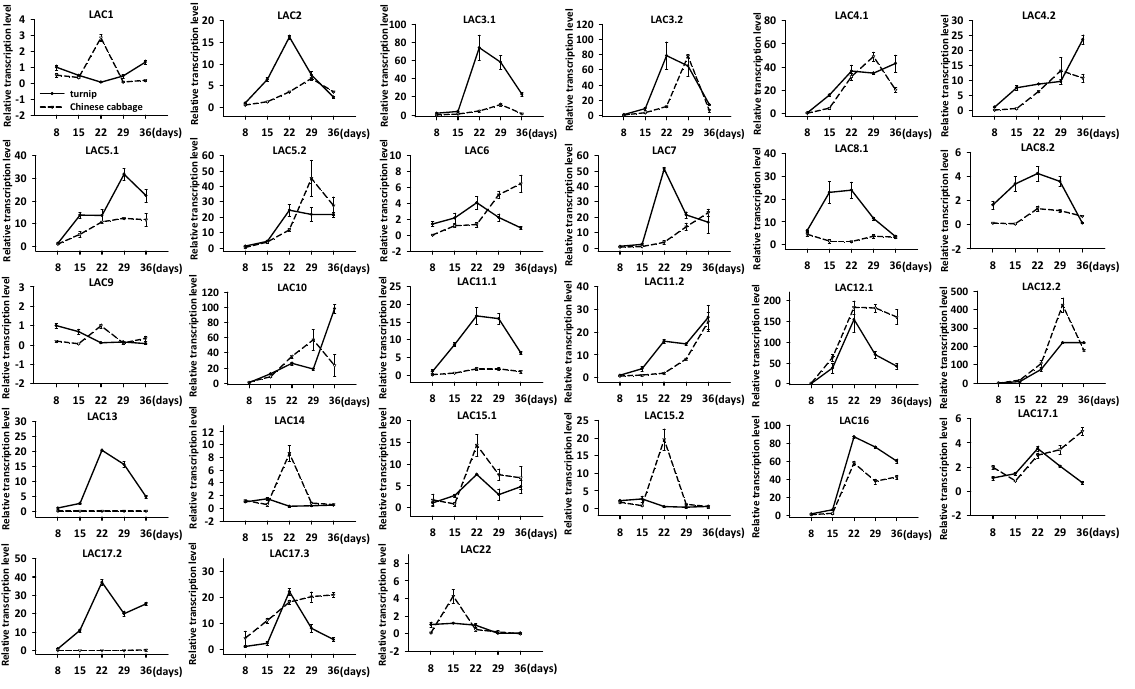
Figure 6. Transcription patterns of LAC genes in early developmental stages of turnip and Chinese cabbage. The hypocotyl of plants was collected at 8 days, 15 days, 22 days, 29 days, and 36 days after sowing. The relative expression level was normalized using TUB gene. Values are the mean and SE of three replicates.